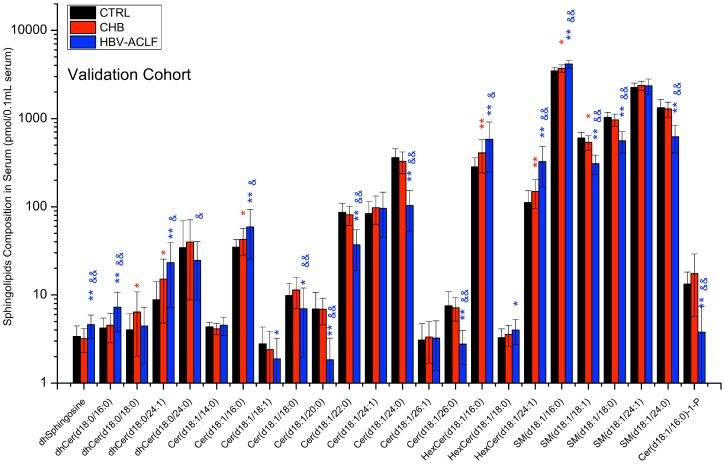
Serum sphingolipid levels in the validation cohort.Data are expressed as the mean ± SEM. *, significant difference compared with healthy control subjects (*  = p<0.05, **  = p<0.01); &, significant difference compared with CHB (&  = p<0.05, &&  = p<0.01).